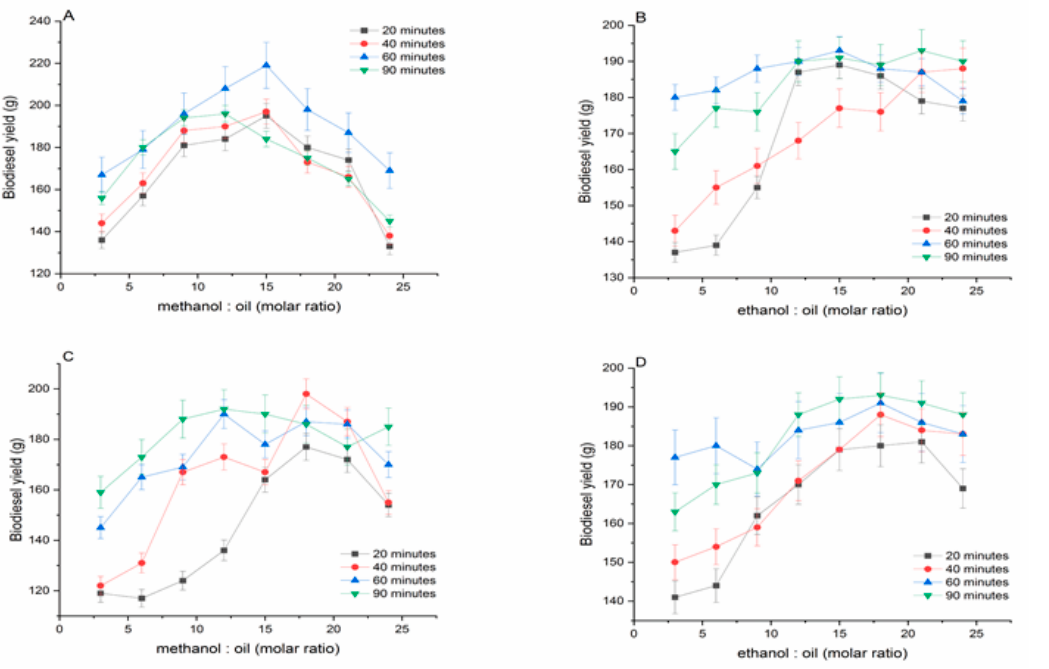
Figure 2. Correlation between the biodiesel yield (g) and the molar ratio of alcohol:oil. ( A , B ) rapeseed oil; and ( C , D ) sunflower oil. Data are reported as the average ± SD (n = 3).